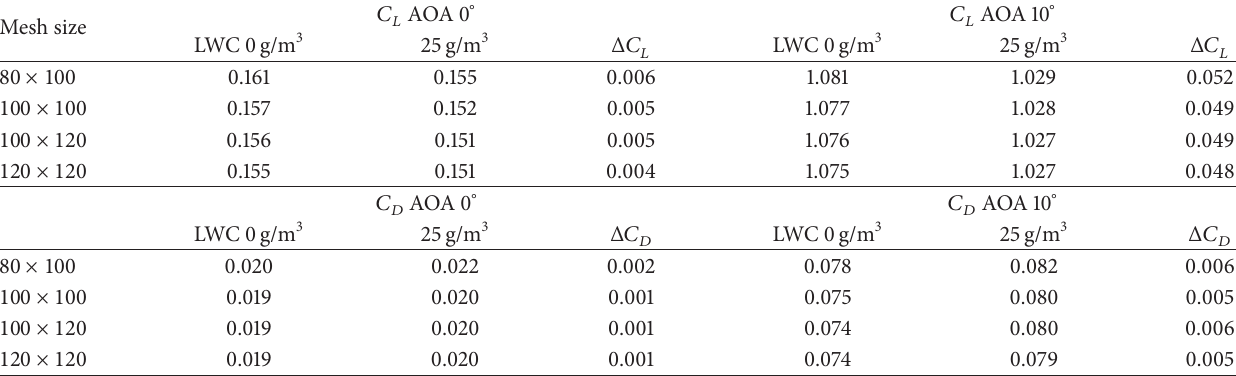
Figure 1: (a) O-type computational domain of meshes for both the original and numerically tripped NACA 64-210 airfoils; (b) near mesh of the original airfoil; (c) near mesh of the airfoil tripped at 5% chordwise station; (d) close view of the tripped position on the 5% chordwise tripped airfoil. Table 1: Lift and drag coefficients for different sizes of the original airfoil